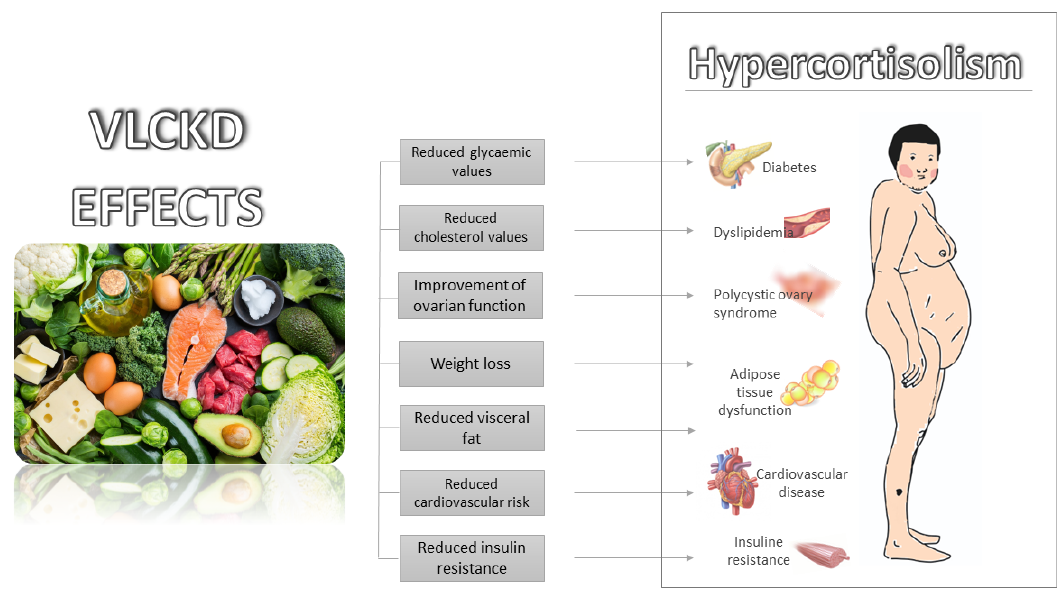
Figure 2. Metabolic effects of VLCKD and potential applications in Cushing’s syndrome comorbidities. To confirm our hypotheses, prospective larger studies on the use of a VLCKD in patients with CS should be